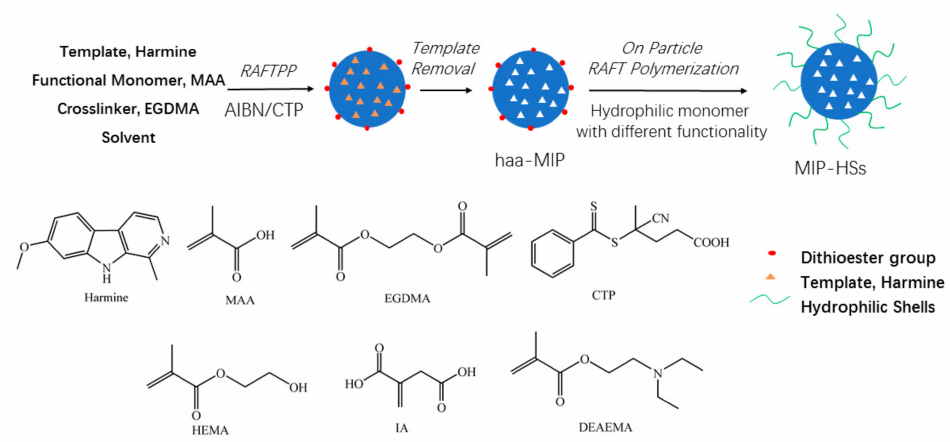
Figure 1. Synthesis pathway of the haa-MIP and the core-shell structural MIP-HSs.